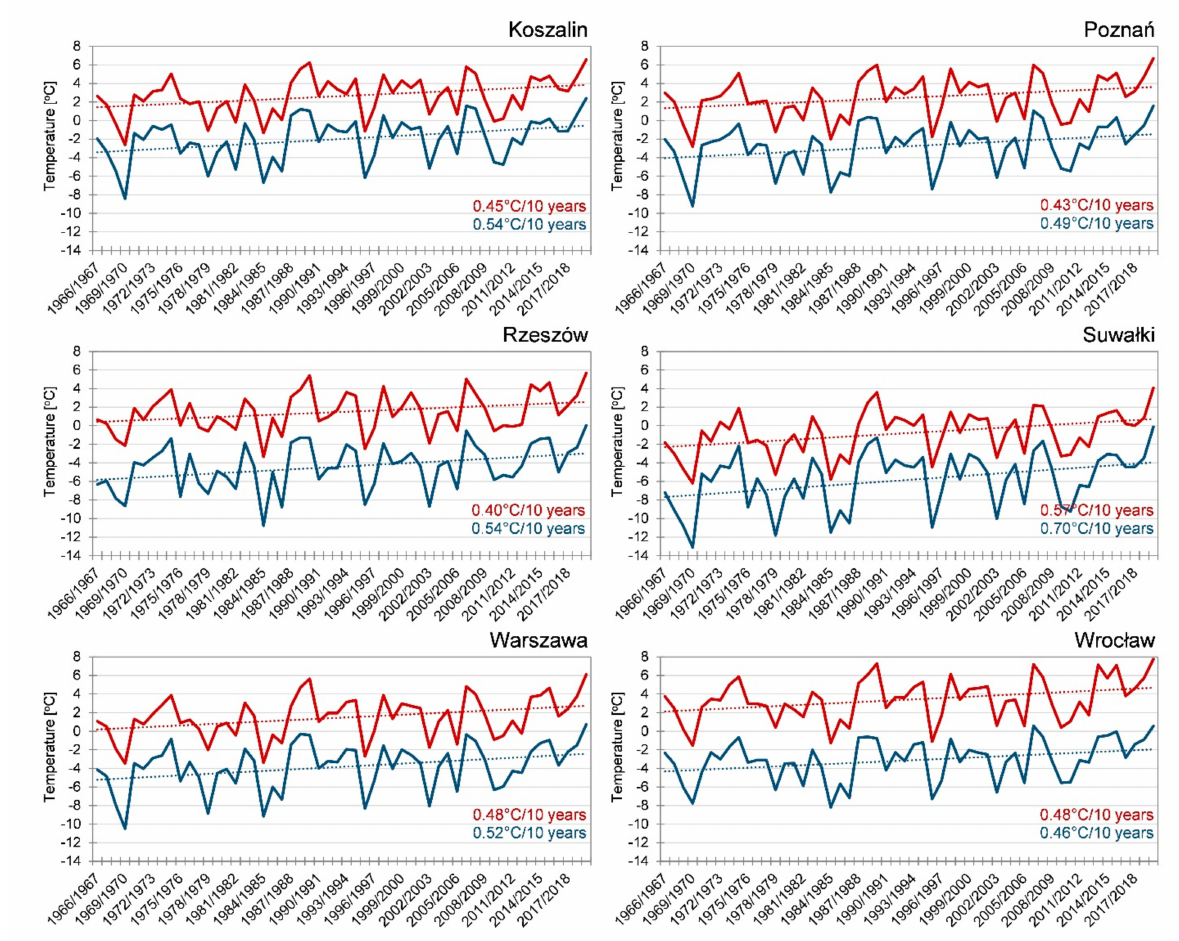
Figure 3. Course of mean Tmin ( blue line ) and Tmax ( red line ) in winter in the years 1966/67–2019/20 with rate of changes. In the analyzed years, the lowest daily Tmin occurred mainly in January, and the highest daily Tmax in the second half of February or at the beginning of December. The lowest daily Tmin over the major area (particularly in the eastern and central regions of the country) was ≤− 30 ◦ C (Figure 4). In particular stations, the absolute minimum Tmin varied from − 35.4 ◦ C in Białystok to − 18.2 ◦ C in Hel. In the majority of stations, the values were recorded in season 1986/87 (particularly on 14.01 and 08.01) and 1984/85 (particularly on 8.01). The highest daily Tmax reached >20 ◦ C in Tarn ó w (20.6 ◦ C; 25.02.1990). In